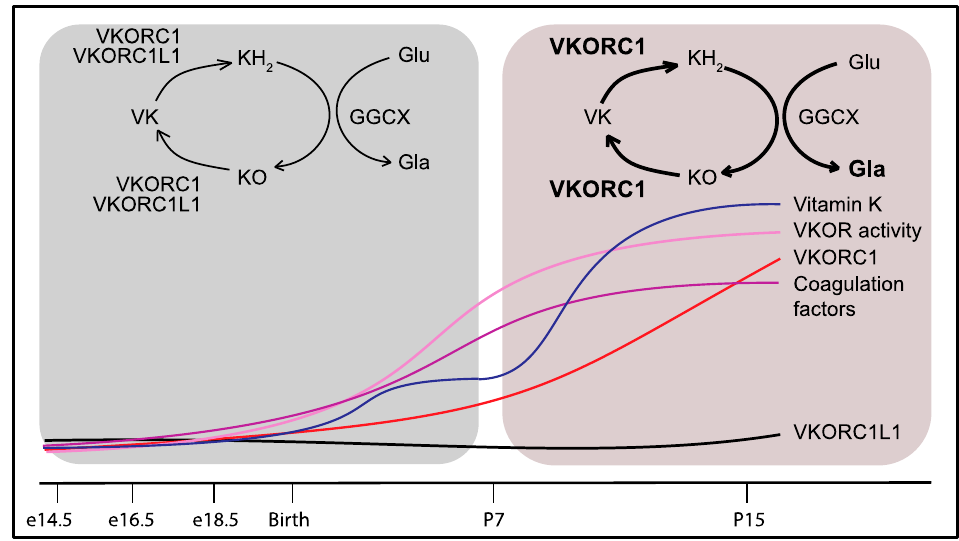
Figure 3. Developmental regulation of VKORC1 and of the vitamin K-dependent coagulation factors in the liver explains the partial redundancy of VKORC1L1. Around birth, VKORC1 and VKORC1L1 both support γ -carboxylation and hemostasis. Beyond P7, VKORC1 expression and activity increase in the liver with the level of vitamin K concomitantly rising in the bloodstream to handle the growing demand for coagulation factor γ -carboxylation. The lower expression levels of VKORC1L1 in the liver after P7 can no longer compensate for the absence of VKORC1 activity. VKORC1: Vitamin K oxidoreductase; VKORC1L1: VKORC1-like 1; VK: Vitamin K; KH 2 : Vitamin K hydroquinone; KO: Vitamin K 2,3-epoxide; GGCX: γ -glutamyl carboxylase; Glu: Glutamic acid residue; Gla: γ -carboxyglutamic acid residue.